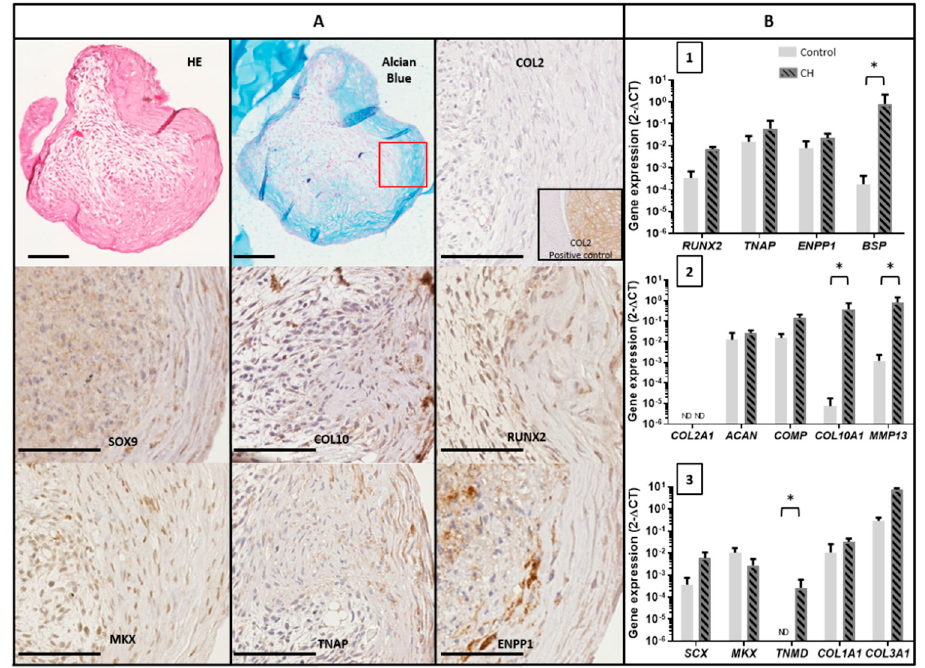
Figure 4. Characterization of TLC cultured in chondrogenic pellets . ( A ) Representative images of histological and immunohistochemical staining of TLC pellets (CH medium) for COL2, SOX9, COL10, RUNX2, MKX, TNAP, and ENPP1. COL2 positive control was obtained with a chondrosarcoma sample. HE: Hematoxylin and eosin. Scale bar 100 µ m. ( B ) Gene expression of TLC cultured four weeks in chondrogenic pellets or in cell monolayer in control medium: levels of expression of osteoblast markers (1), chondrocyte markers (2) and tenocyte markers (3) ( N = 3) assessed by qPCR.* = p < 0.05.